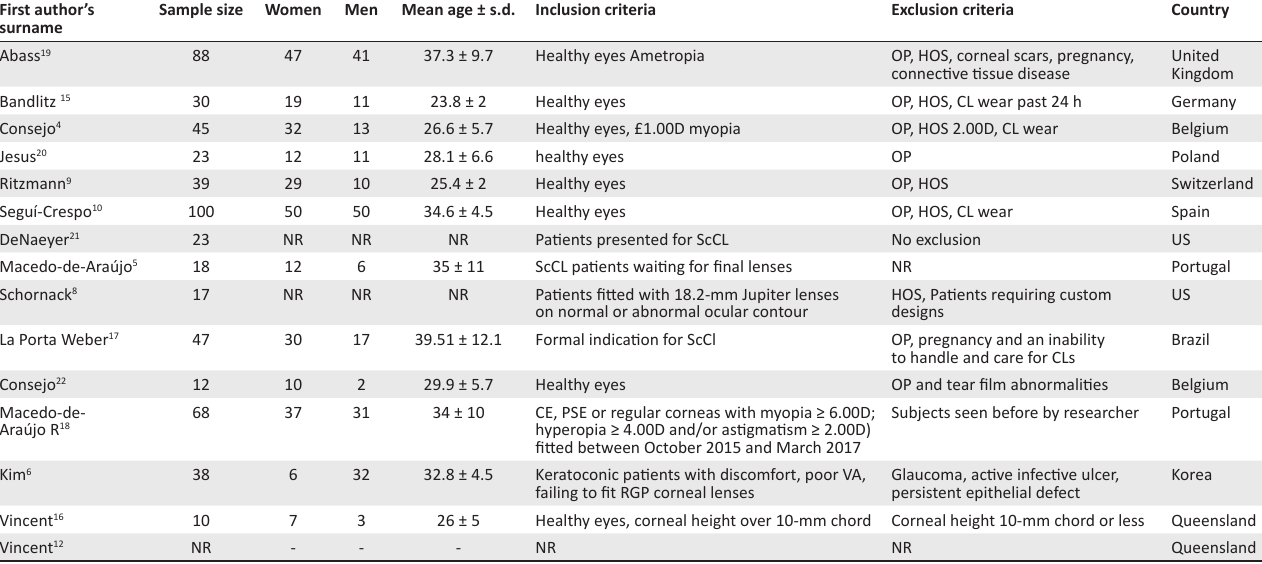
TABLE 2: Sample size, gender and mean age of the subjects, and inclusion or exclusion criteria and country of publication of the reviewed studies. First author’s Sample size Women Men Mean age ± s.d. Inclusion surname